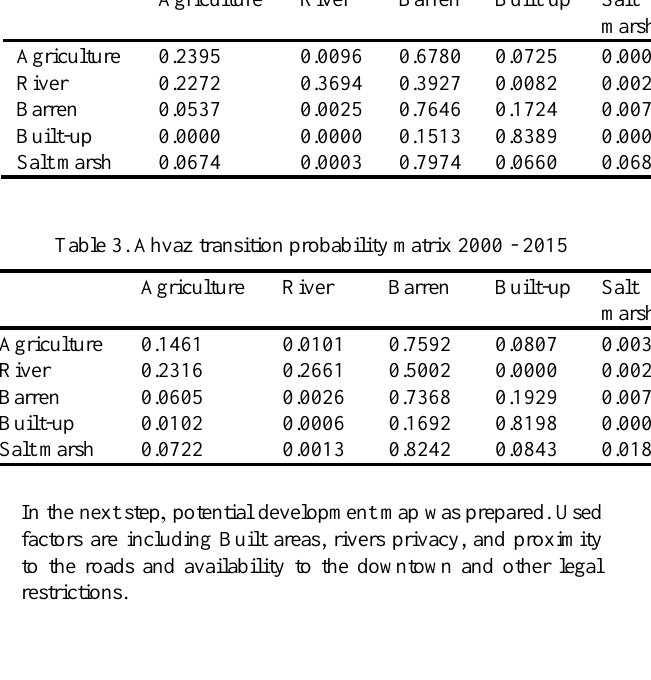
Figure 3. Classification result